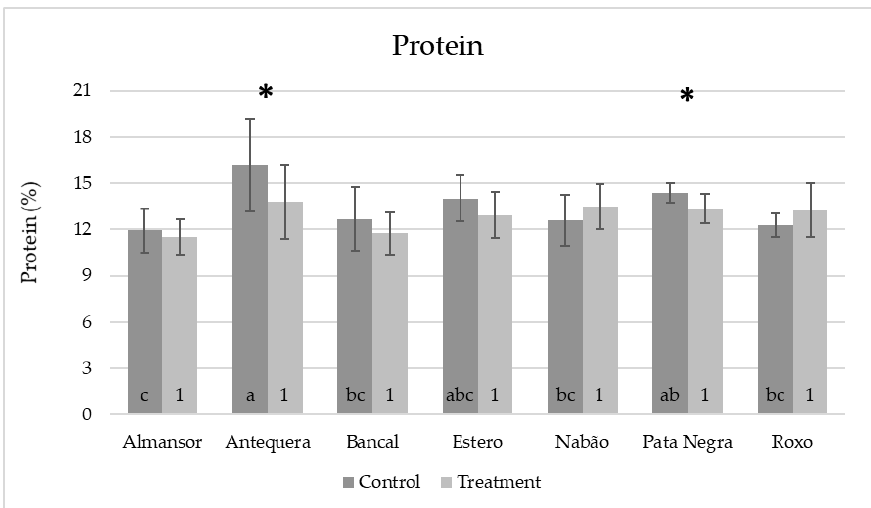
Figure 5. Mean values of predicted protein contents in single milled grains from control (dark gray) and high temperature treated (light gray) plants. Means and standard deviation values (represented as bars). Di ff erent letters (control) and numbers (treatment) inside bars indicate ANOVA significant di ff erences between varieties detected by multiple means comparison test. (*) indicates t -test statistical di ff erences between control and treatment in each variety ( p < 0.05).